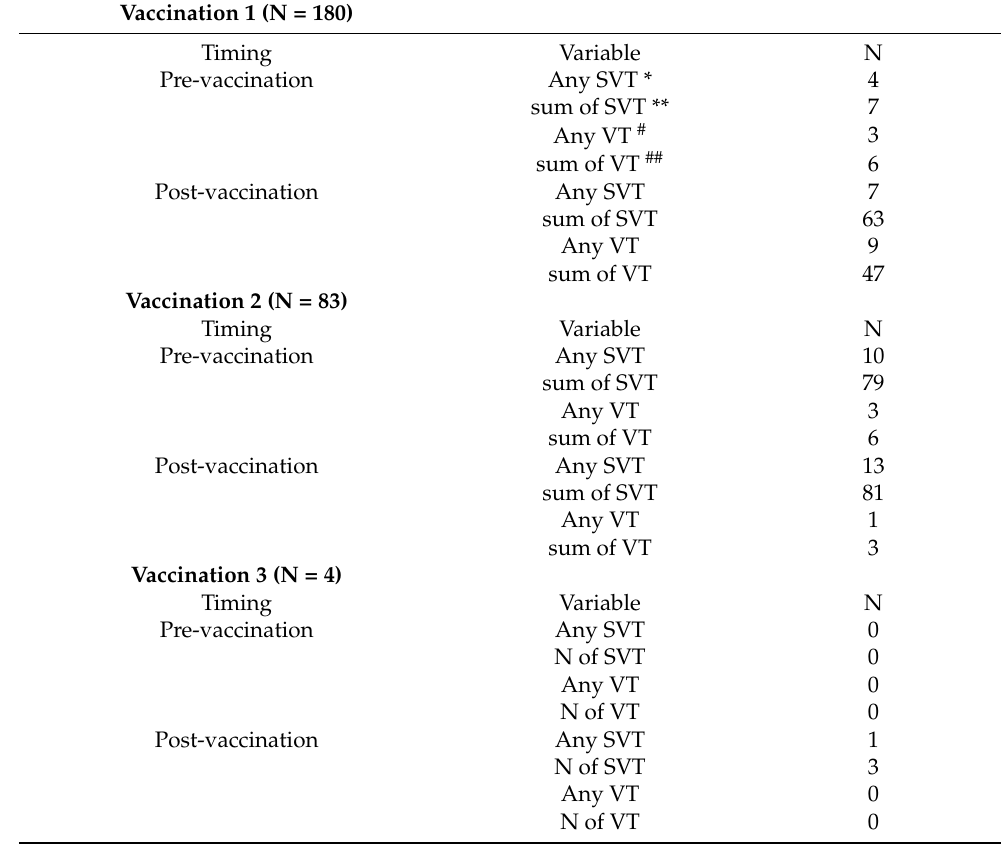
Table 3. Distribution of VT and SVT pre- and post-